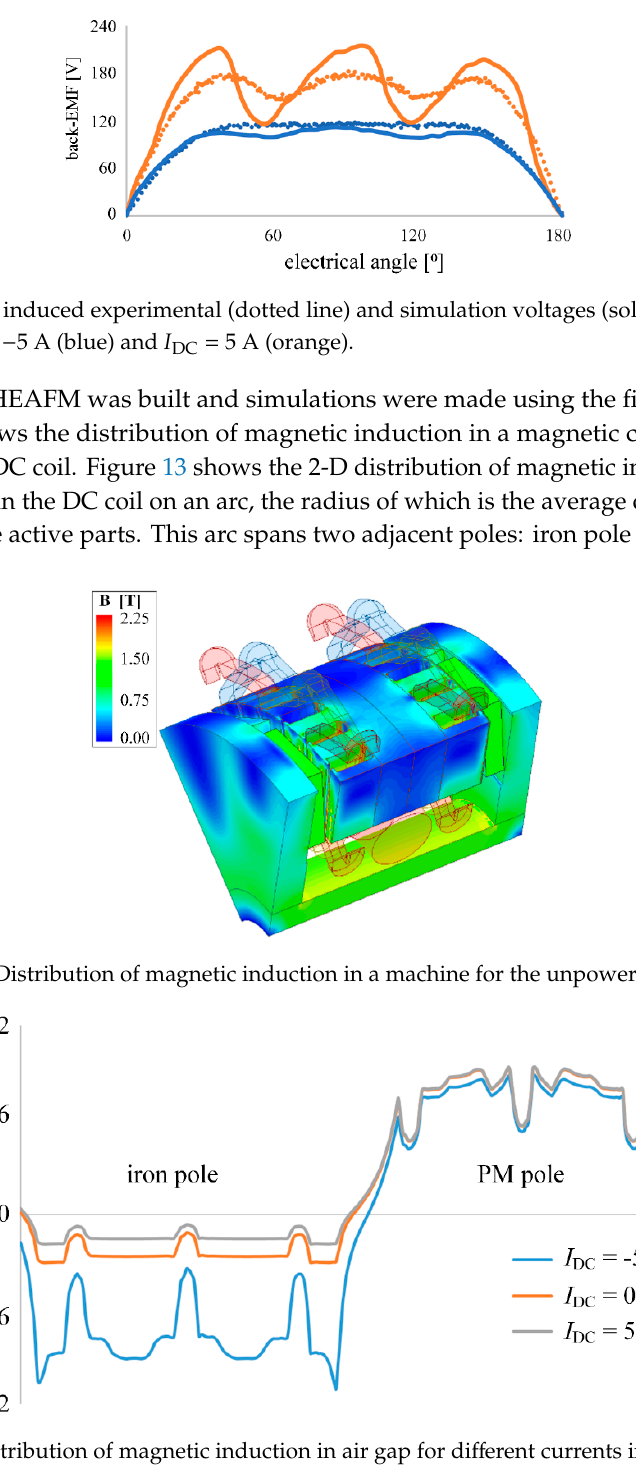
Figure 10. Experimental stand [55].